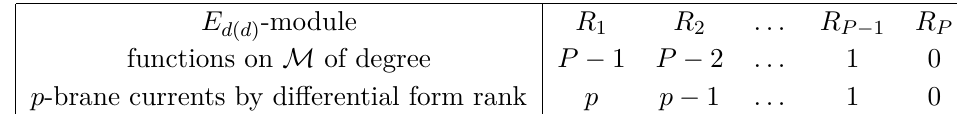
module is strictly larger p +1 − n